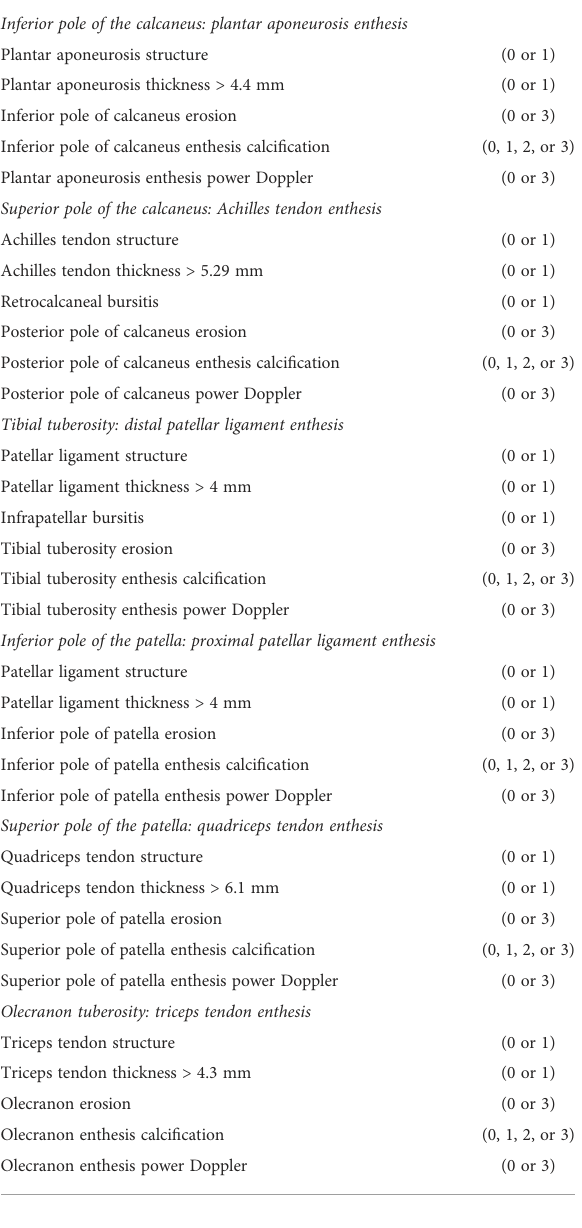
TABLE 5 Madrid Sonographic Enthesis Index (MASEI) (Ref. de Miguel et al., Ann Rheum Dis , 2009., 68(2): 169 – 74). Data